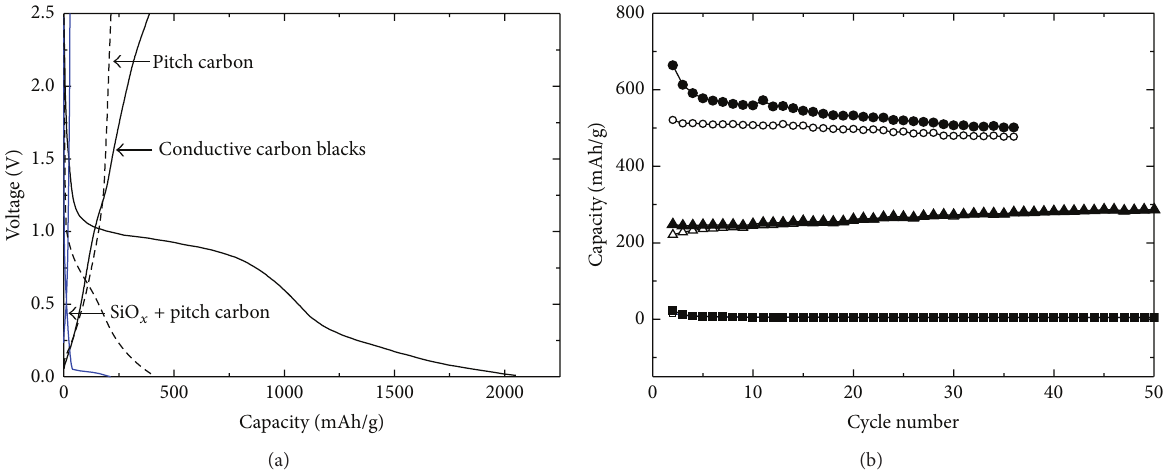
Figure 4: I - V characteristics during the 1st cycle of electrochemical charging/discharging (a) and the cyclic stabilities of charging (closed data)/discharging (open data) test results for the 2nd to the 50th cycle (b) for various electrodes, such as conductive carbon blacks ( e , I ), pitch carbon ( 󳵳, △ ), and SiO 𝑥 + 30 wt% pitch carbon ( ◼,◻ )